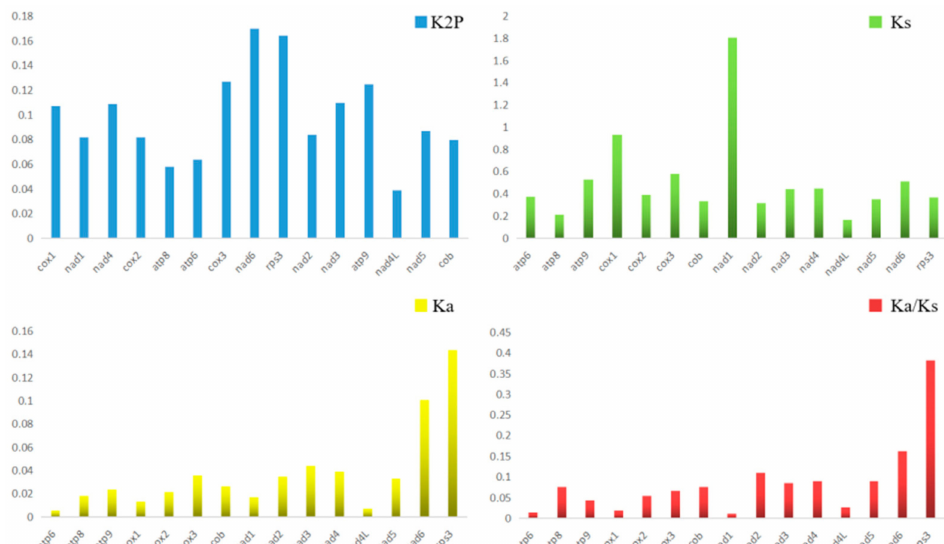
Figure 7. Genetic analysis of the 15 core protein-coding genes among four Clonostachys mitogenomes. (K2P, the Kimura- 2-parameter distance; Ka, the number of nonsynonymous substitutions per nonsynonymous site; Ks, the number of synonymous substitutions per synonymous